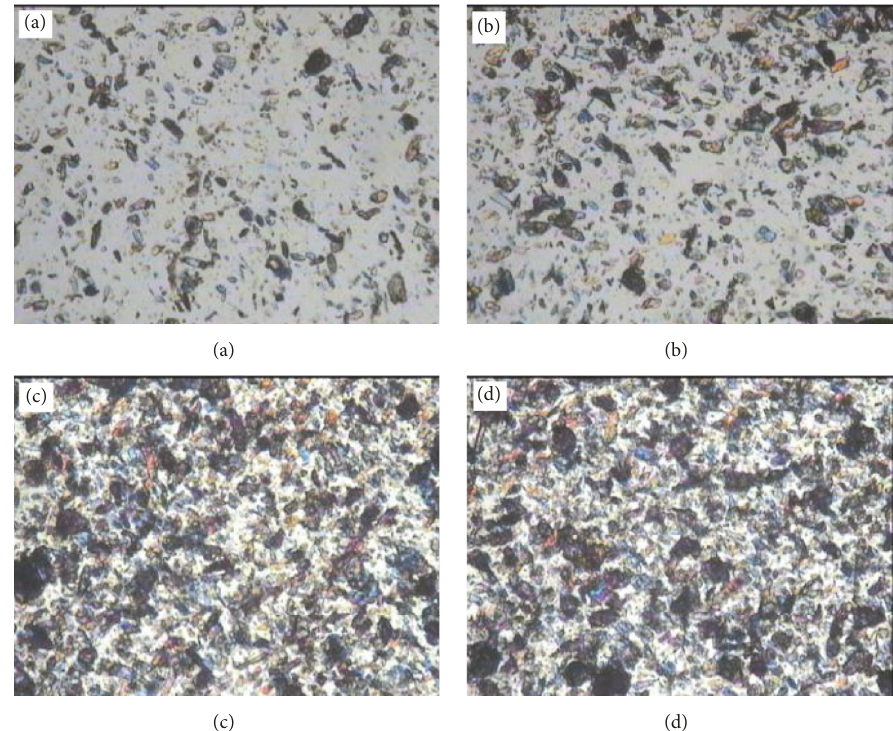
Figure 4: Polarized light photomicrographs showing the intensity and distribution of MCC particles within molten PP after inclusion of 2 wt% PP-g-MA: (a) 5, (b) 10, (c) 20, and (d) 40 wt% MCC [magnification =